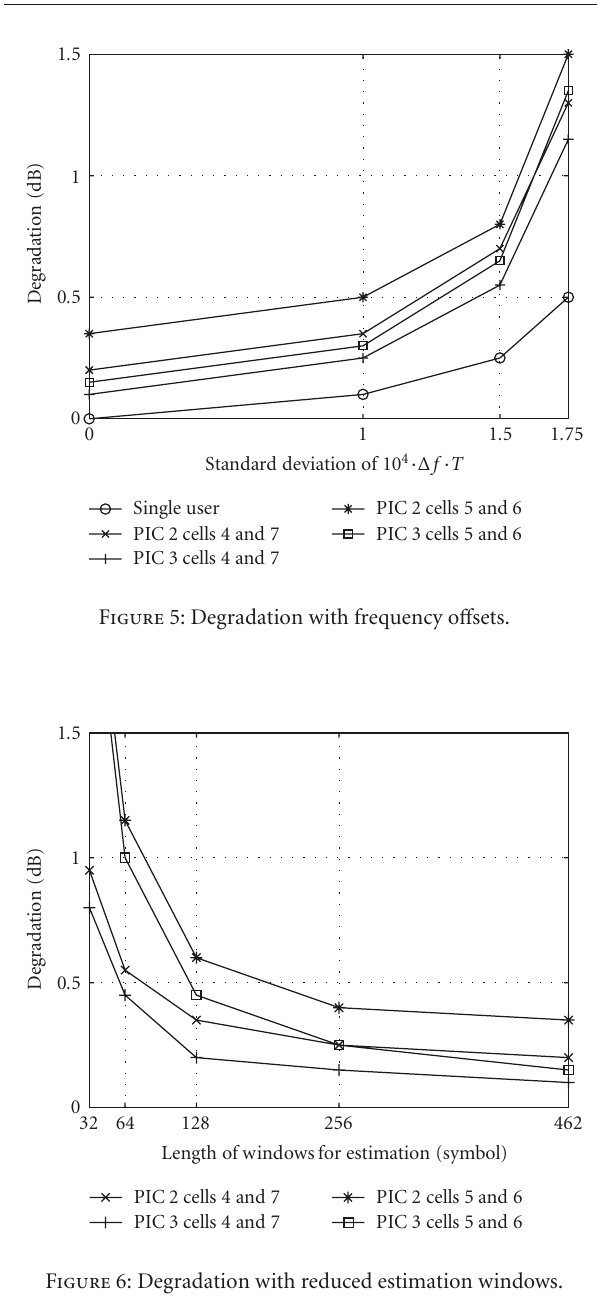
Figure 6: Degradation with reduced estimation